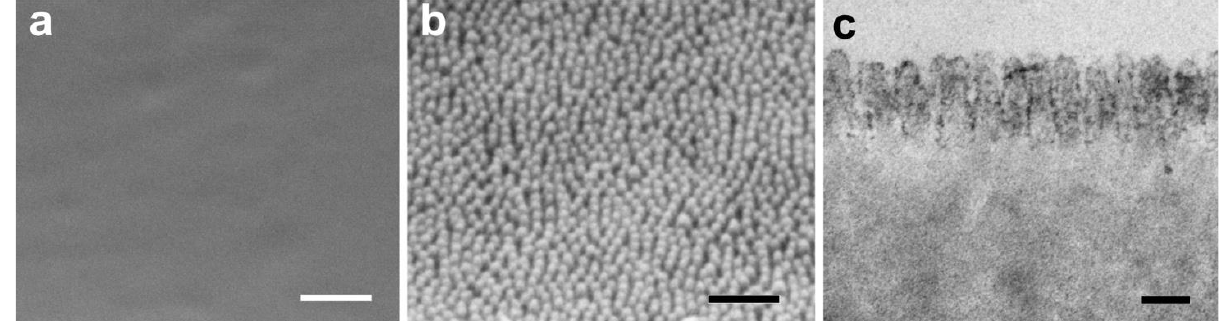
Figure 1. Ultrastructure of the film surface in scanning electron microscopy (SEM: ( a , b )) and trans- mission electron microscopy (TEM: c ). ( a ), flat film; ( b , c ), MOSMITE™. Scale bars: 0.5 µm in ( a , b ); 0.1 µm in ( c ).